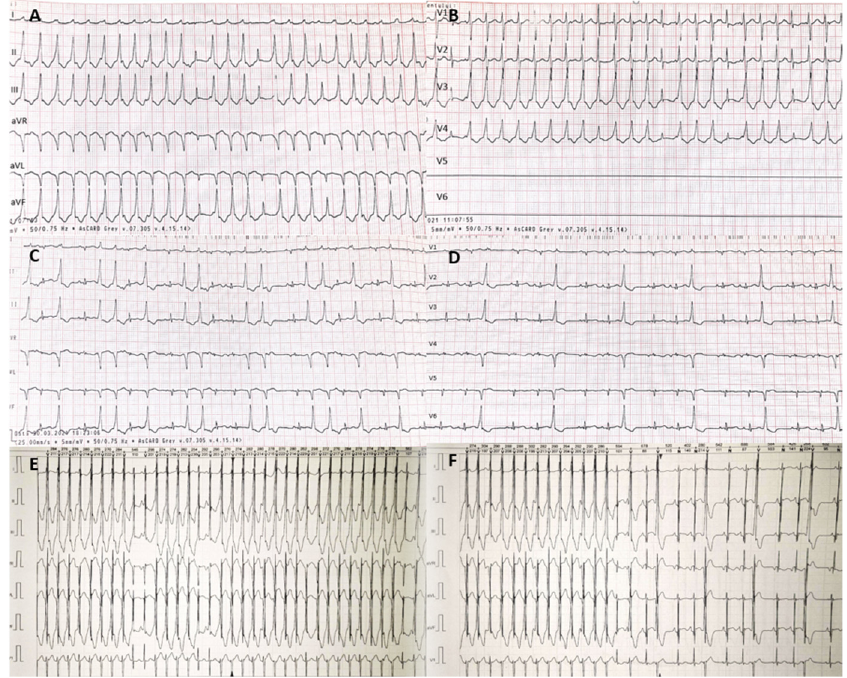
Figure 3. Electrocardiograms and 24-h electrocardiograms. ( A , B )—electrocardiograms showing ventricular tachycardia-dissociated activity of atria and ventricles, ventricular rate: 220–230/min, fusion beats and capture beats; ( C , D )—electrocardiograms showing ventricular bigeminy and trigeminy; ( E , F )—24-h electrocardiograms showing ventricular tachycardia. The newborn was hemodynamically stable; however, she was transferred to the